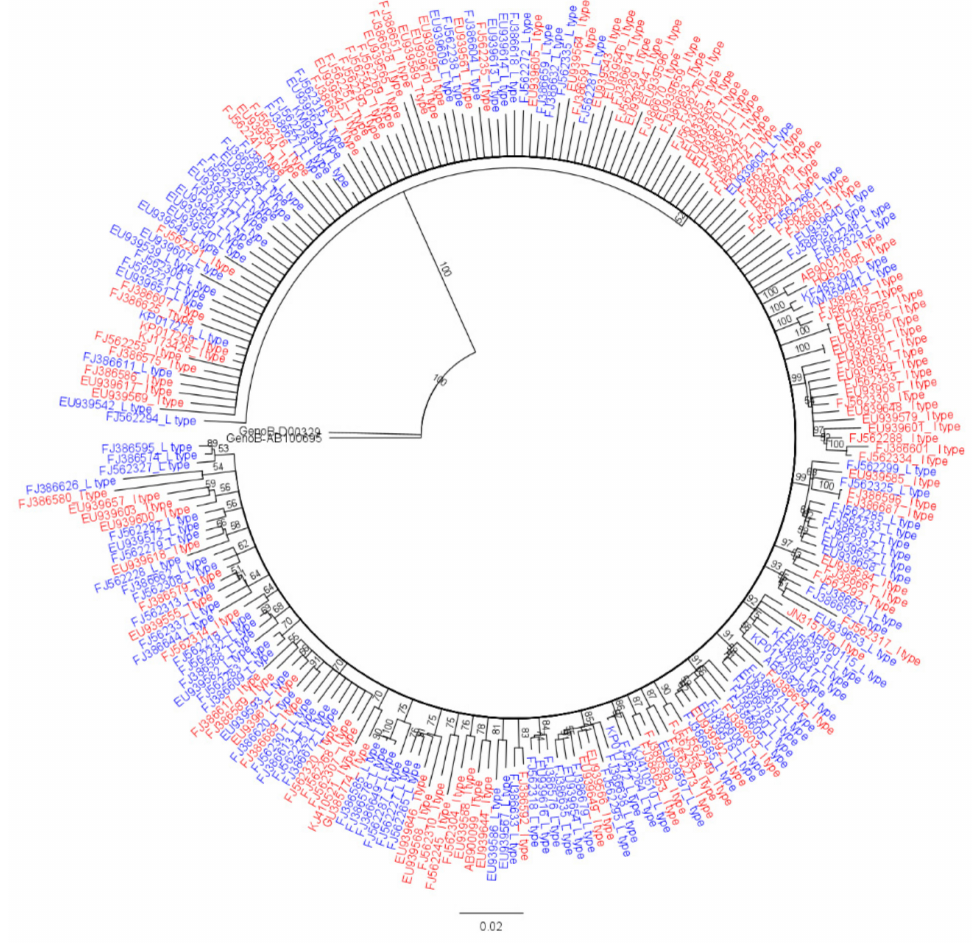
Figure 1. Genotype determination of selected HBV genomes via phylogenetic analysis. Phylogenetic tree of a total of 234 HBV sequences belonging to genotype C2 was conducted by the neighbor-joining method using Tamura–Nei genetic distance model. A total of 100 replicate bootstrap tests were conducted using a genotype B sequence as an outgroup. rt269L and rt269I sequences labeled “L” and “I” at the end of accession